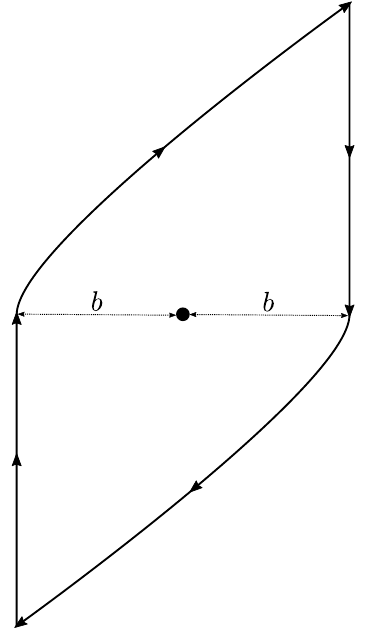
Figure 1 . Closed contour as a product of Wilson